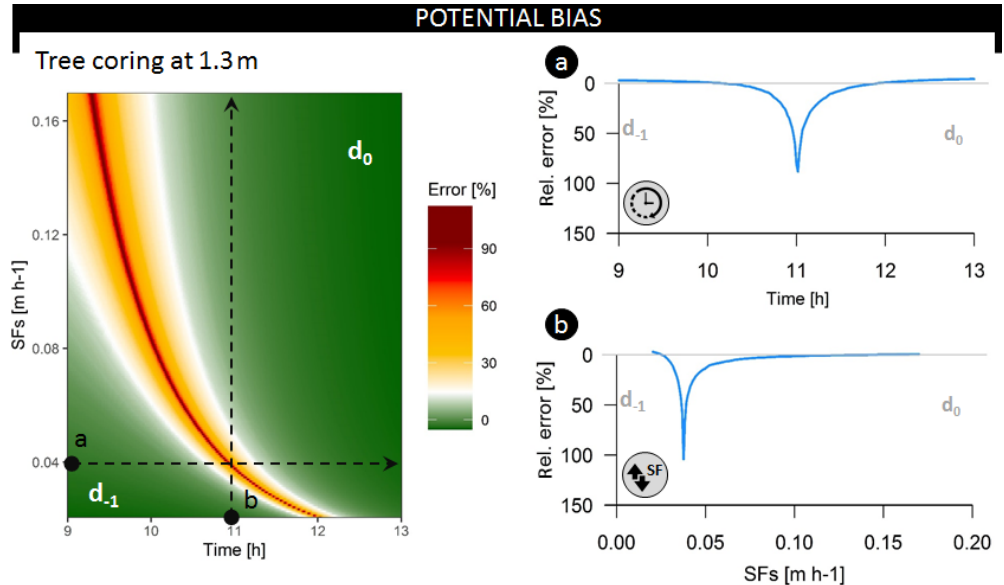
Figure 5. Relative error on the inferred average root water uptake depth (i.e., bias between the average daily and the instantaneously derived average RWU depth) at a coring height of 1.3m throughout the common sampling period (09:00 until 13:00) and over a range of potential SF S values (in mh − 1 ), corresponding to an SF V range of 0.15–1.25mh − 1 . Both dotted lines describe test scenarios evaluated in the breakup panels. Respectively, d − 1 and d 0 indicate whether the derived average RWU depth error corresponds to the previous or current day of measurement. The dynamics in relative error are when sampling (a) over different time steps and restricting sap flux density at 0.04mh − 1 (i.e., SF V = 0 . 28mh − 1 ) or (b) over different SF S values when restricting sampling time to 11:00LT each